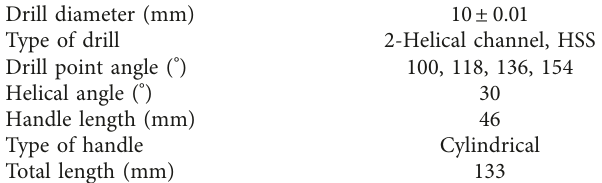
Figure 2: (a) Tool grinding machine and (b) drills with different point angles. Table 2: Characteristics of HSS drill points.